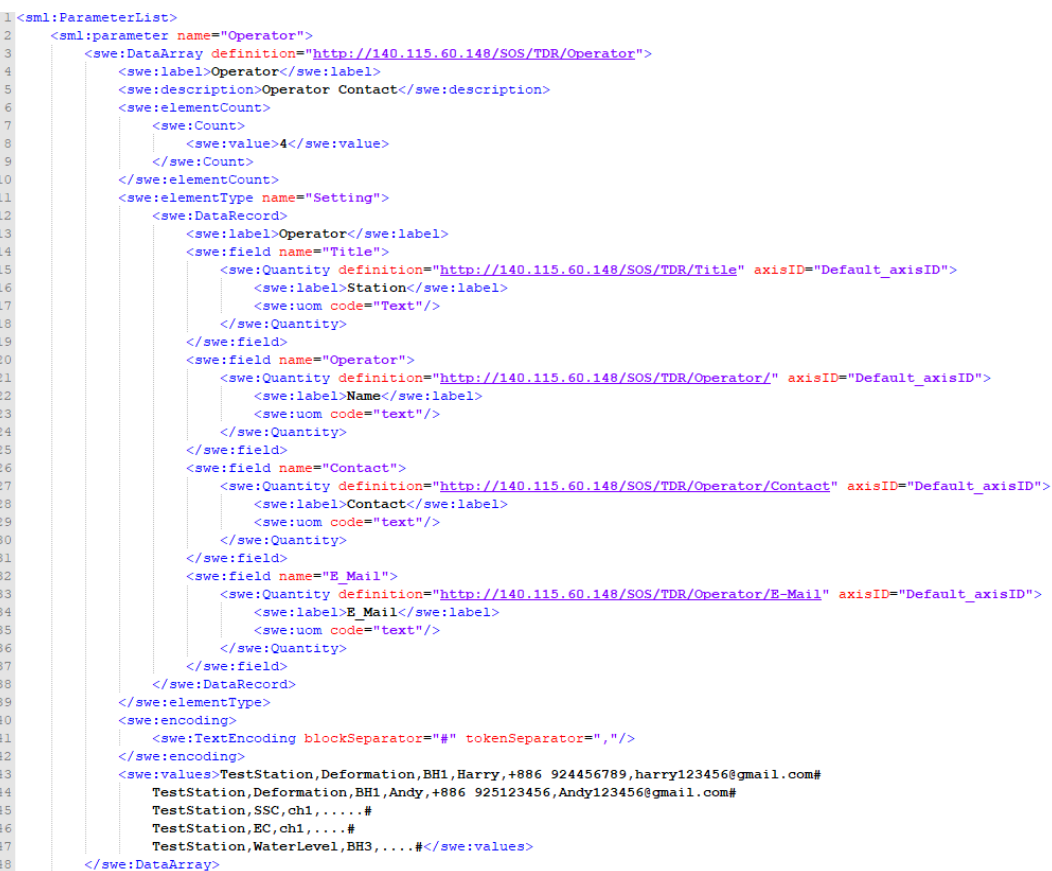
Figure 10. Extended InsertSensor format for Operator.